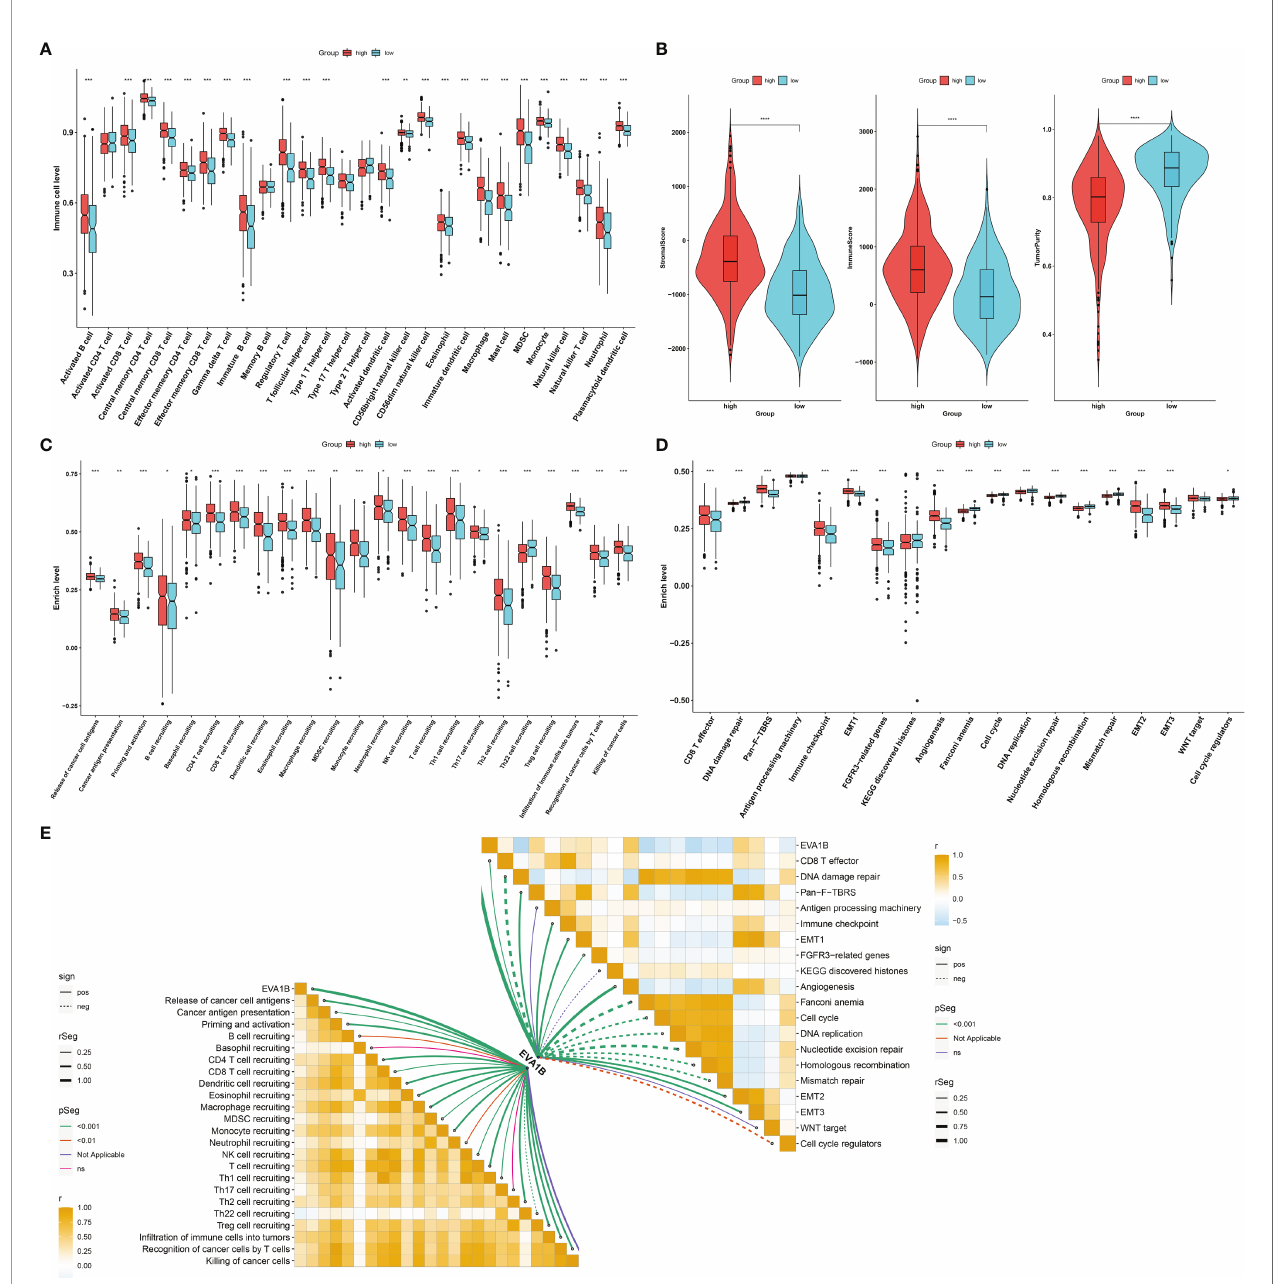
FIGURE 4 | Immunological and biological signi fi cance of EVA1B in CRC. (A) Comparison of the in fi ltration of immune cells between high and low EVA1B expression subpopulations. (B) Evaluation of the difference in stromal score, immune score, and tumor purity in high and low EVA1B expression subpopulations. (C) Quanti fi cation of the activities of cancer immunity cycle in two subpopulations. (D) Comparing the activation of known biological signatures in two subpopulations. (E) Associations of EVA1B expression with the activities of cancer immunity cycle and known biological signatures across CRC specimens. (* p < 0.05; ** p < 0.01; *** p <